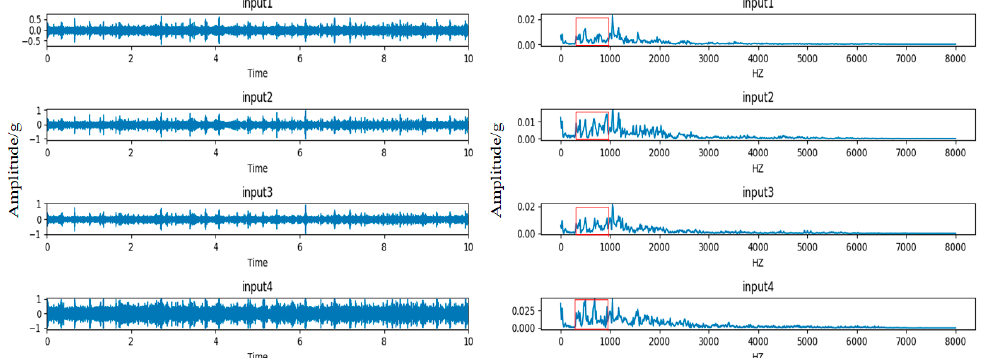
Figure 8. Waterfall diagrams of four different types of gears under two-load conditions. ( A ) Represents a no-load condition and ( B ) represents a load condition.